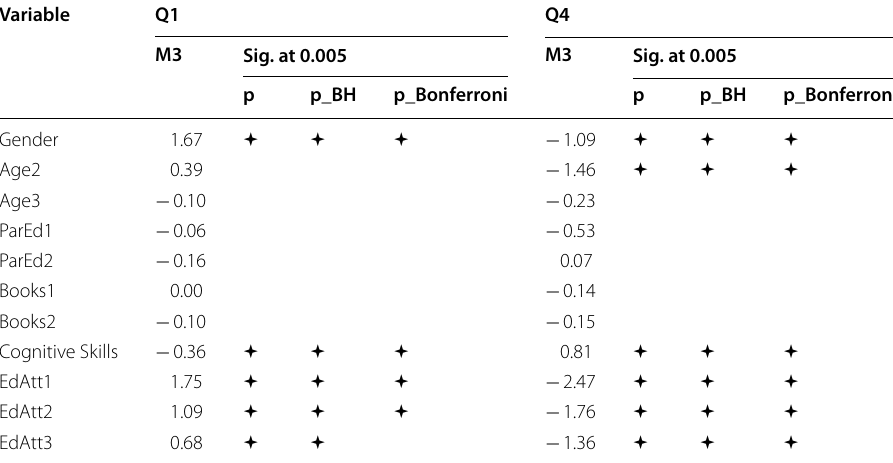
Table 11 Results from M3 [Q1 and Q4]: Germany